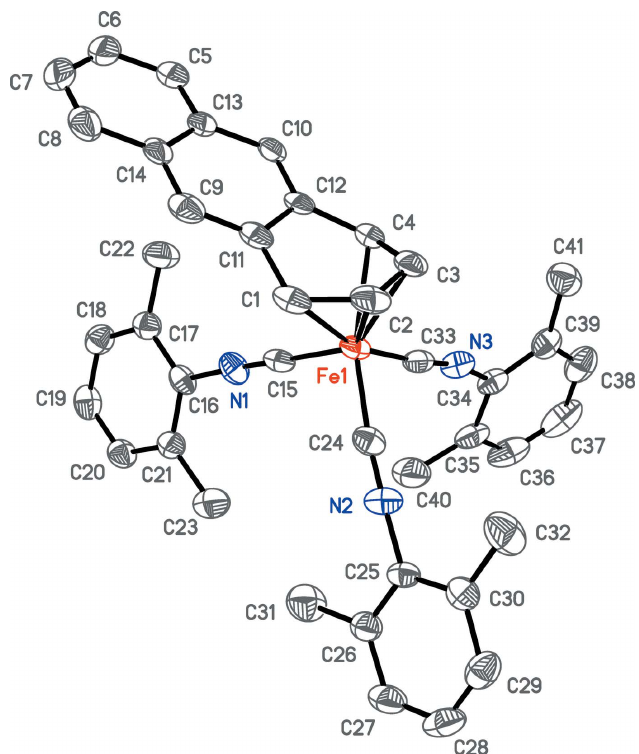
Figure 1 Anisotropic displacement ellipsoid plot of 1 drawn at the 50% probability level with H atoms omitted.